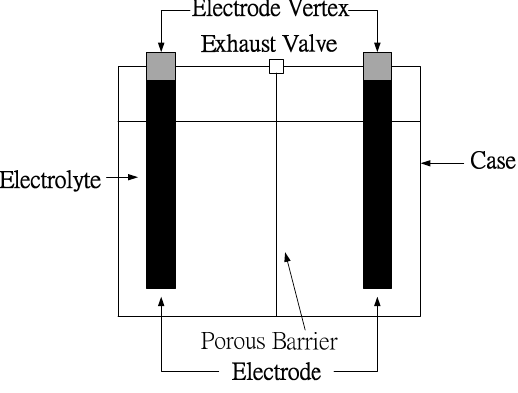
Figure 1. The structure of a lead ‐ acid battery.